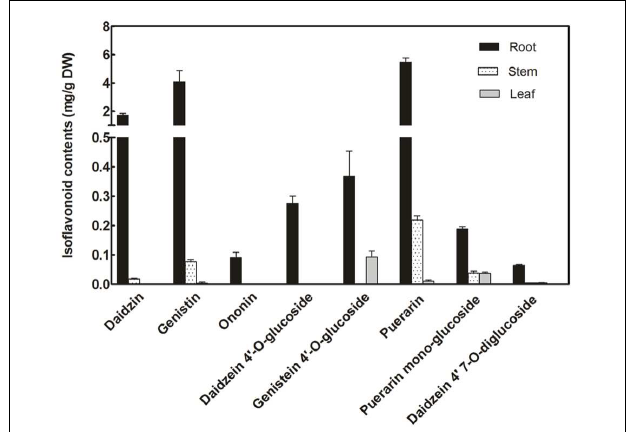
FIGURE 2 | Concentrations of isoflavone glucosides biosynthesized in different organs of P. lobata .